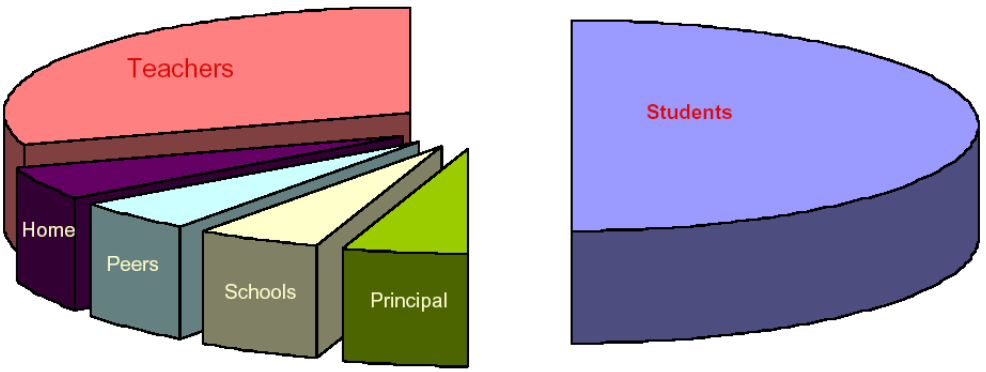
Figure 1. Factors contributing to student achievement ([77], p. 3).